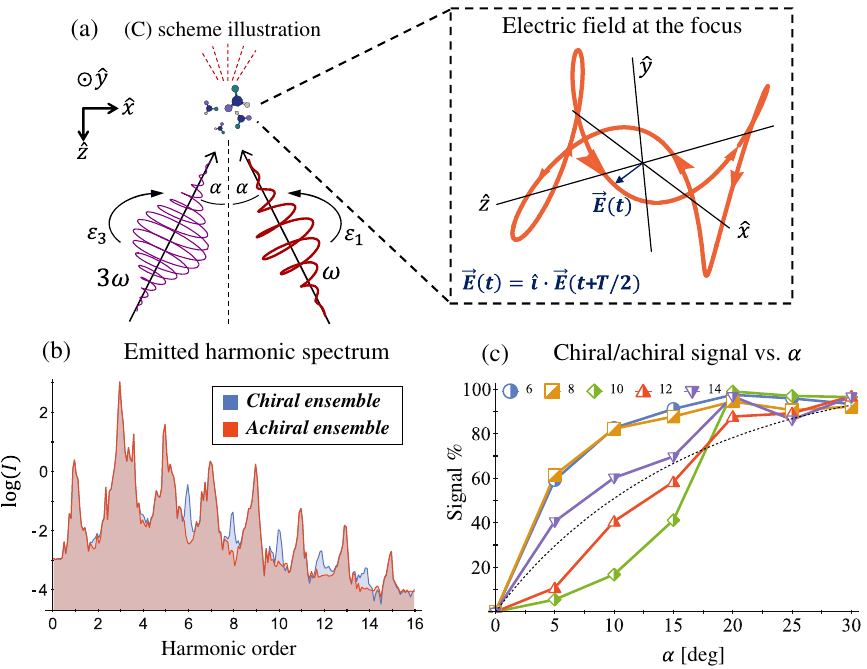
10 13 W = cm 2 , max ¼